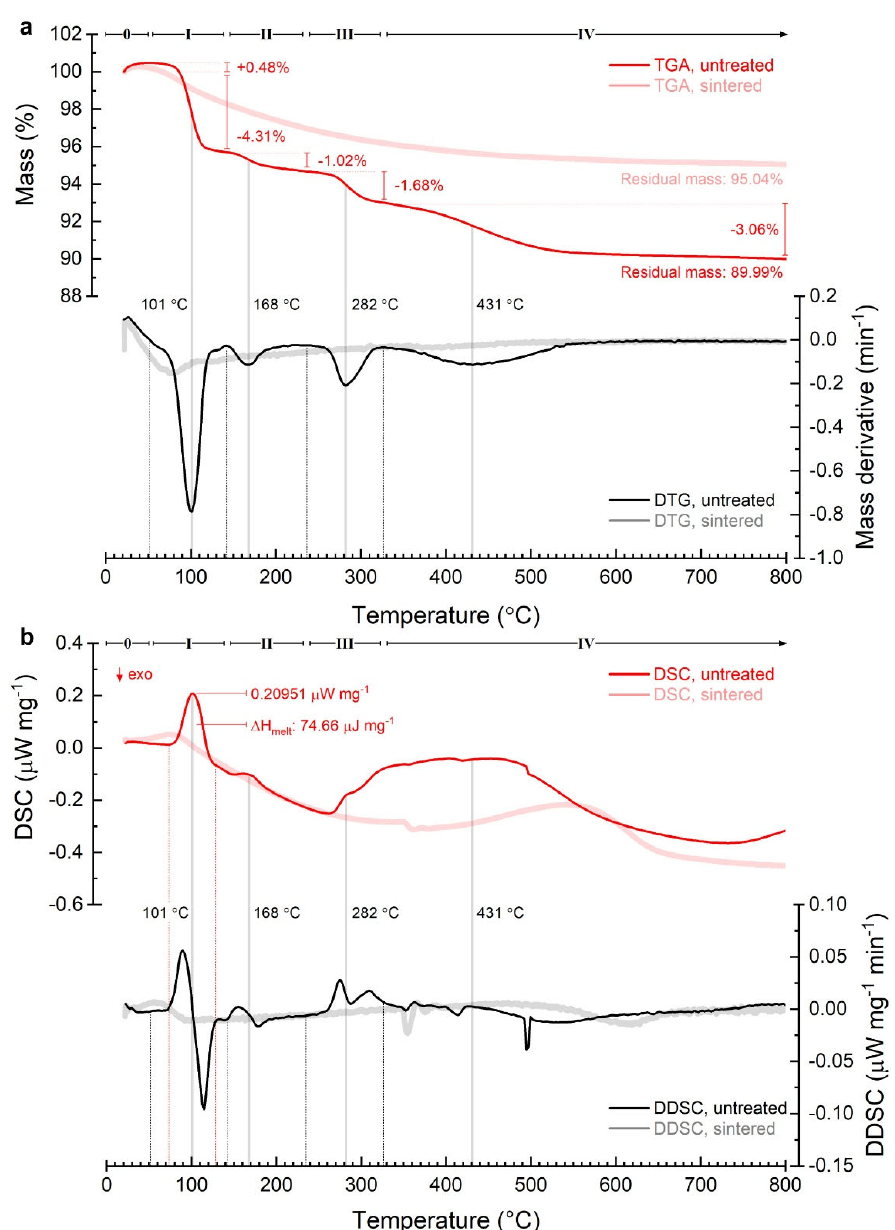
Figure 3. ( a ) TGA and ( b ) corresponding DSC with derived differential curves (DTG, DDSC) of untreated NASICON vs. thermally treated powders (shaded curves). Major thermal events and corresponding identifiers marked accordingly.